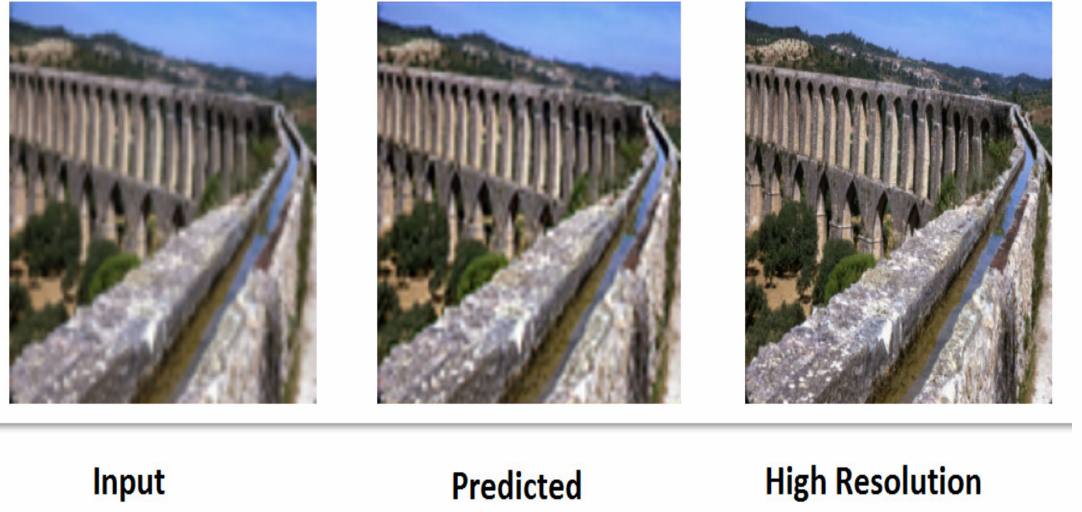
Figure 16. Input, Predicted, and Ground truth